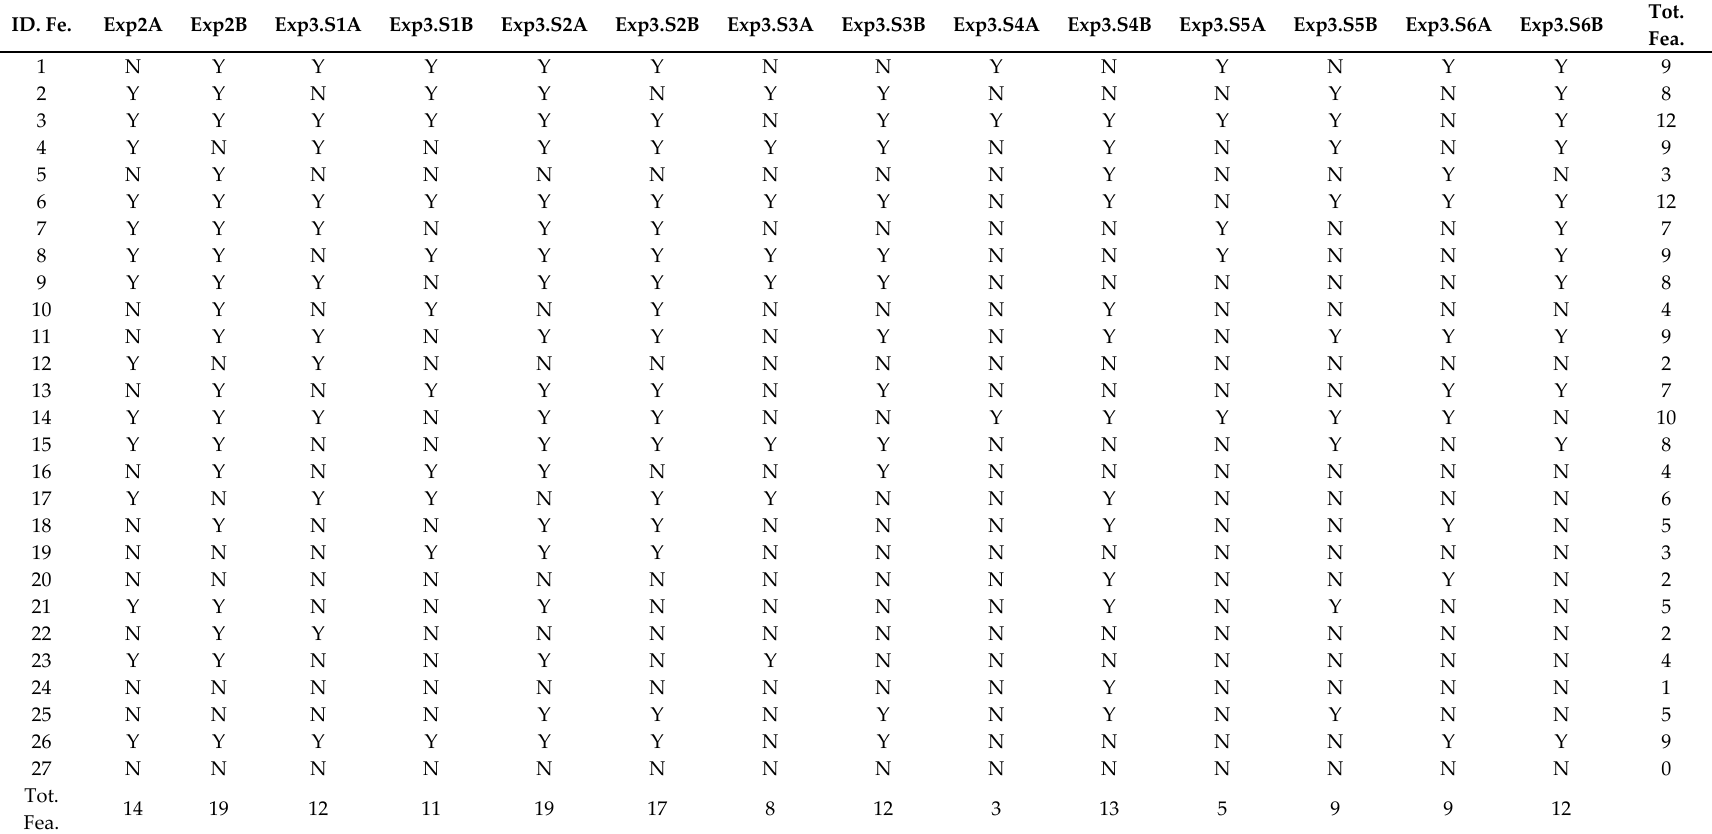
Table 3. Features considered in each